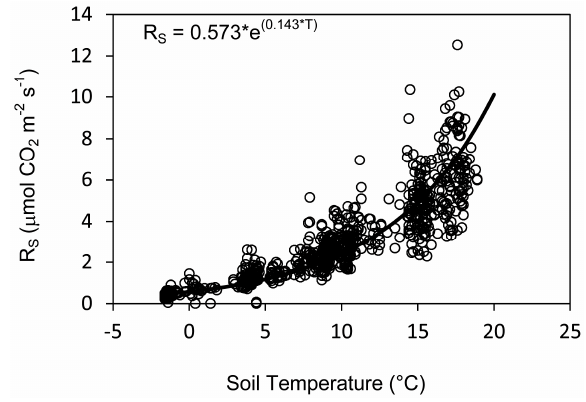
Figure 3. Relationships between soil respiration (R S ) and soil temperature in red pine stands in northern Minnesota, USA.